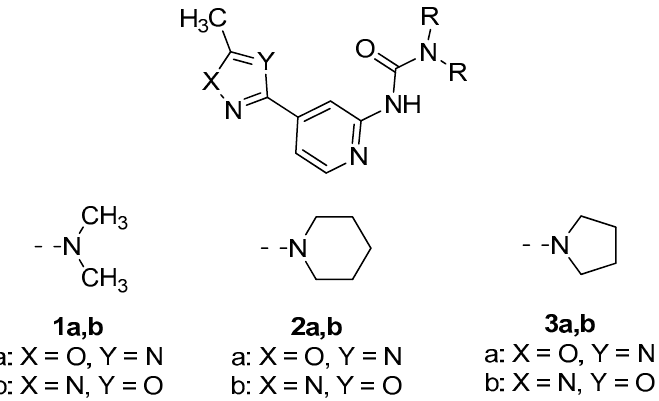
Figure 1. N -Pyridyl ureas bearing oxadiazole moiety considered in this study.